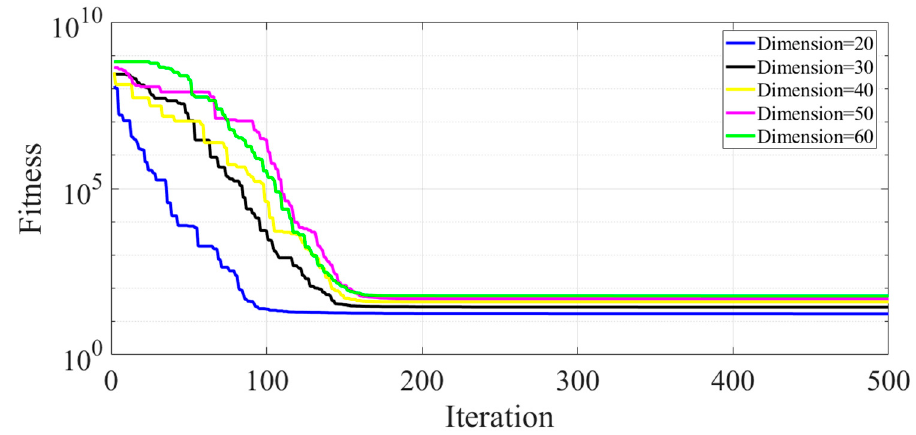
Figure 9. Comparison of parametric results with different numbers of dimensions in the HMSCACSA.